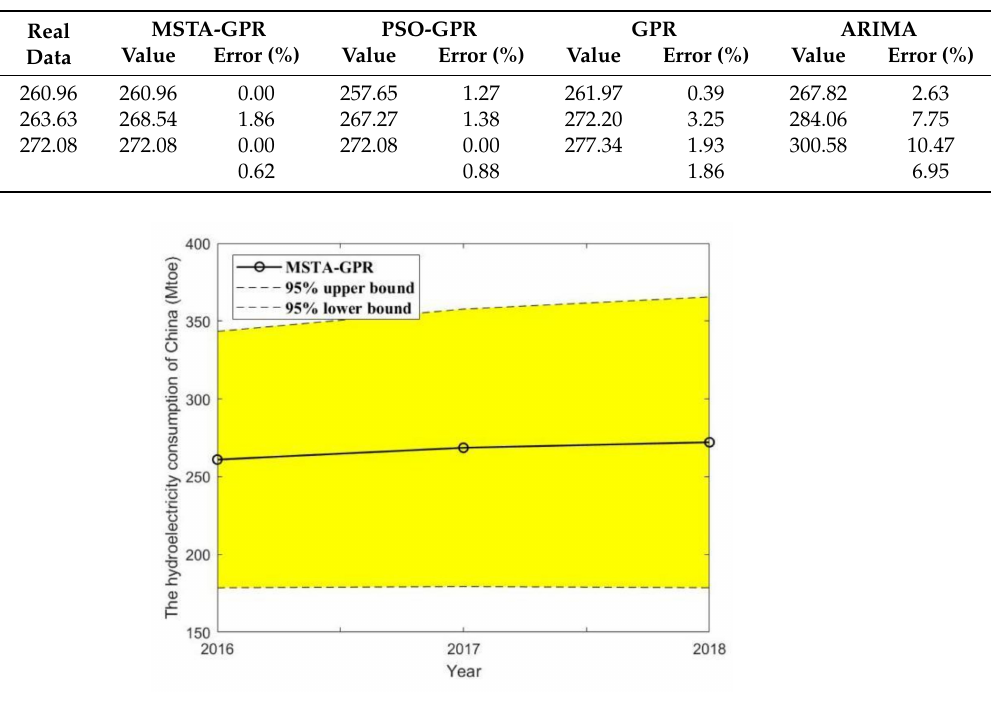
Table A1. Consumption prediction for hydroelectricity of China from 2016 to 2018 (Mtoe).